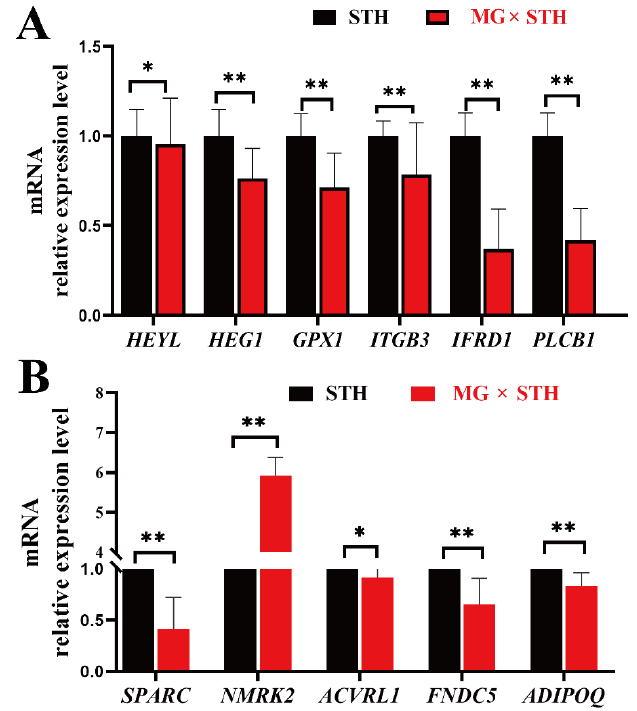
Figure 6. Validation of 11 target DEGs in terms of transcriptome and correlation analysis data. ( A ) qRT-PCR analysis of six DEGs validated for transcriptome data. ( B ) qRT-PCR analysis of five DEGs validated for trait-associated correlation analysis data. The values were calculated using the 2 −ΔΔCt method: * p < 0.05, ** p < 0.01.